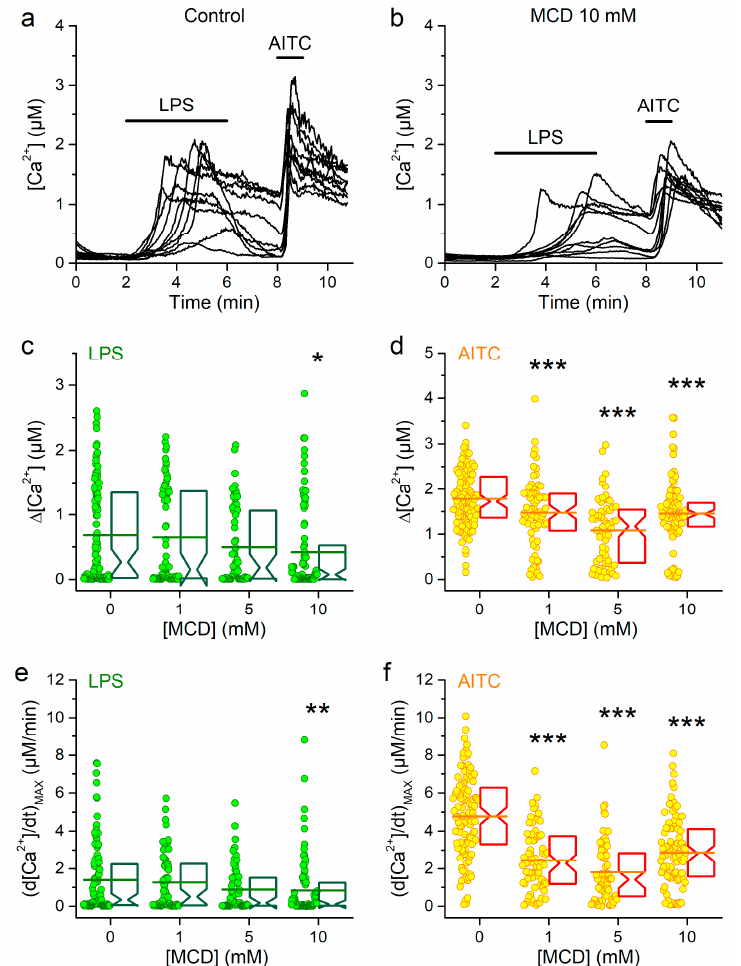
Figure 3. E ff ects of cholesterol depletion using MCD on mTRPA1 responses to LPS. ( a and b ) Representative [Ca 2 + ] traces showing the e ff ects of E. coli LPS (20 µ g / mL) in control condition ( a ) and after pretreatment with 10 mM MCD ( b ). Application of AITC (100 µ M) was used as control for mTRPA1 activation. ( c and d ) Amplitudes of [Ca 2 + ] responses to LPS ( c ) and AITC ( d ) in control ( n = 102) or after pretreatment with 1 ( n = 72), 5 ( n = 64) or 10 mM ( n = 90) of MCD. Maximal amplitude of the first time derivative of the intracellular Ca 2 + signal elicited by LPS ( e ) and AITC ( f ) in control condition or after treatment with 1, 5 or 10 mM of MCD (the n numbers are the same as in panels c and d). The symbols *, ** and *** indicate p < 0.05, p < 0.01 and p < 0.001, respectively; Kolmogorov–Smirnov